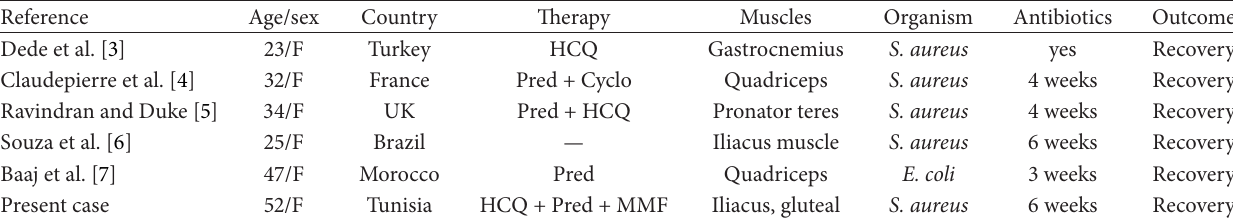
Table 1: Clinical features of pyomyositis in patients with systemic lupus